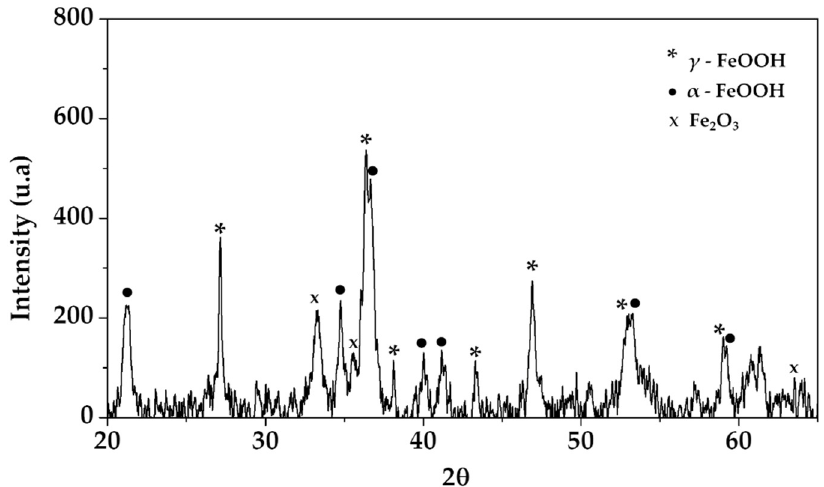
Figure 2. XRD spectra of the corrosion layer formed on carbon steel B450C surface, after exposure for 30 days to SS1 cement extract solution.